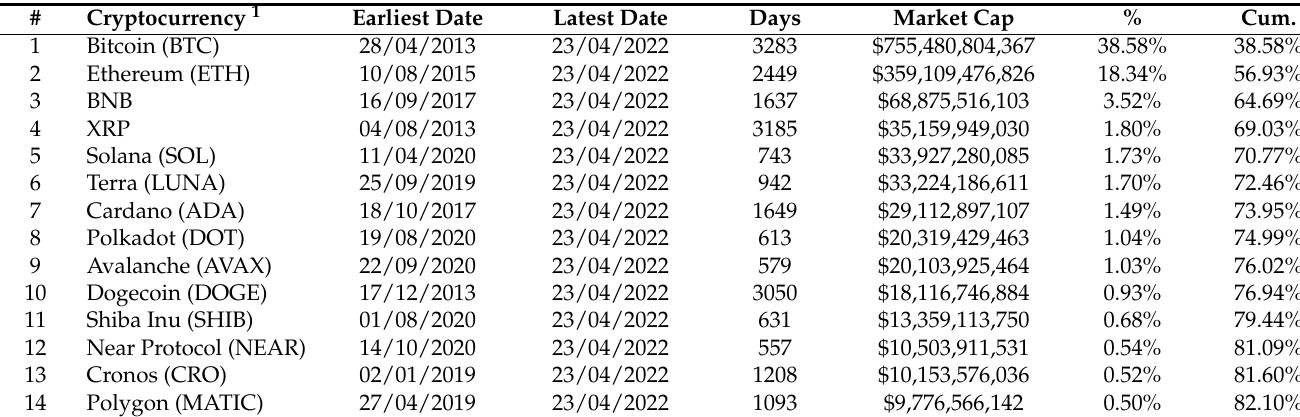
Table 2. Selected portfolio of